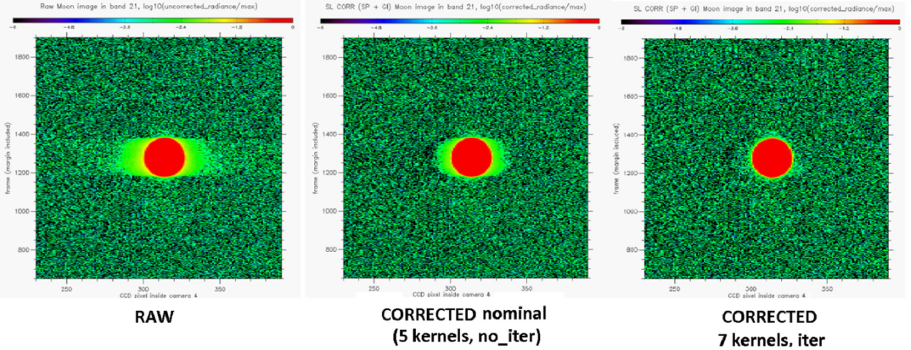
Figure 5. Oa21 moon radiance ( left ) without stray-light correction, ( center ) after nominal correction, ( right ) after correction using seven kernels and iterative method. Plotted radiances are normalized to maximum and log-scaled to highlight the stray-light impact on the deep-space background around the moon disk. It cannot be compared to that of Figure 4.